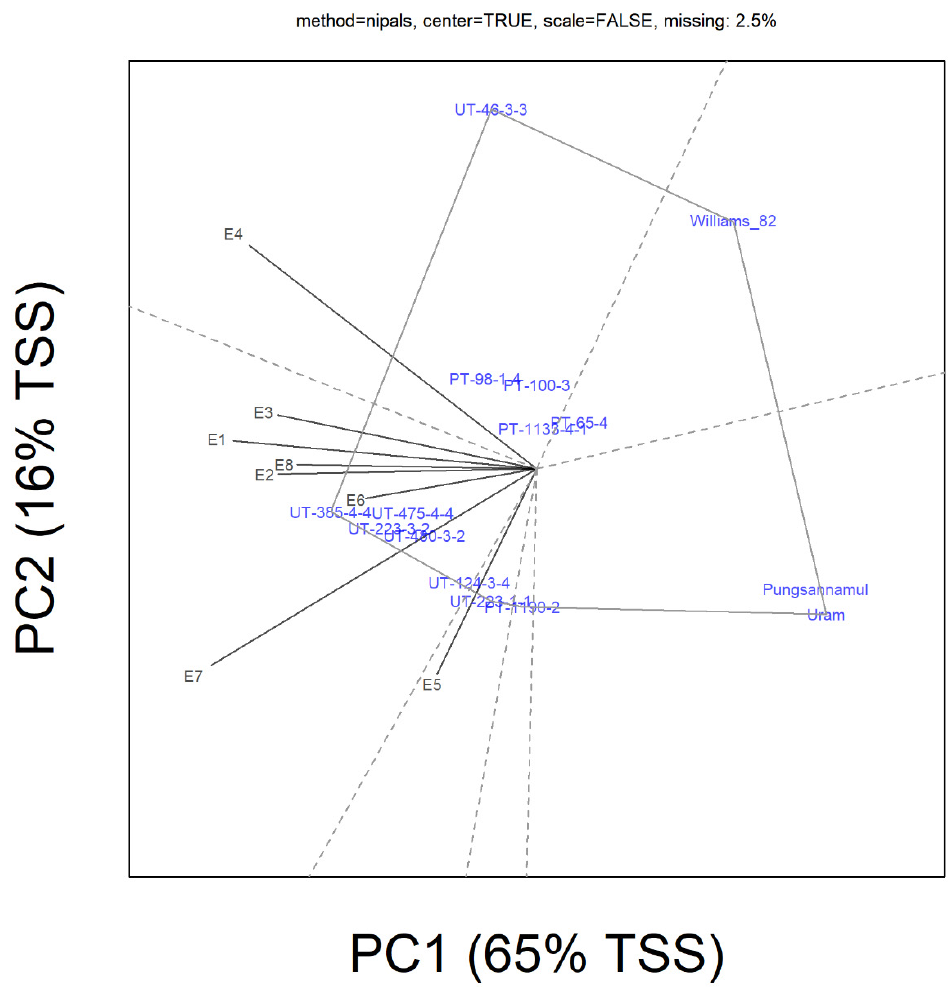
Figure 1. The which-won-where of the genotype plus genotype by environment (GGE) biplot to explain the accumulation of linolenic acid in multiple environments. PC1 and PC3 are the first and second principal components, respectively. E1, Vietnam in 2018; E2, Vietnam in 2019; E3, Laos in 2018; E4, Laos in 2019; E5, Gunwi, South Korea, 22 May 2018; E6, Gunwi, South Korea, 19 Jun 2018; E7, Gwangju, South Korea, 29 May 2018; E8, Gwangju, South Korea, 29 Jun 2018; TSS, total sum of squares.